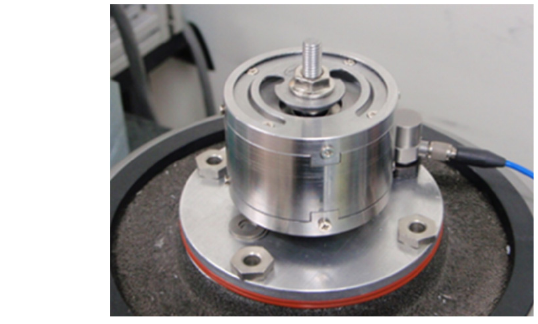
Figure 1. Schematic of the metal spring vibration ‐ energy ‐ harvesting (VEH) device structure ( left ) and the metal spring VEH device for the test ( right ).